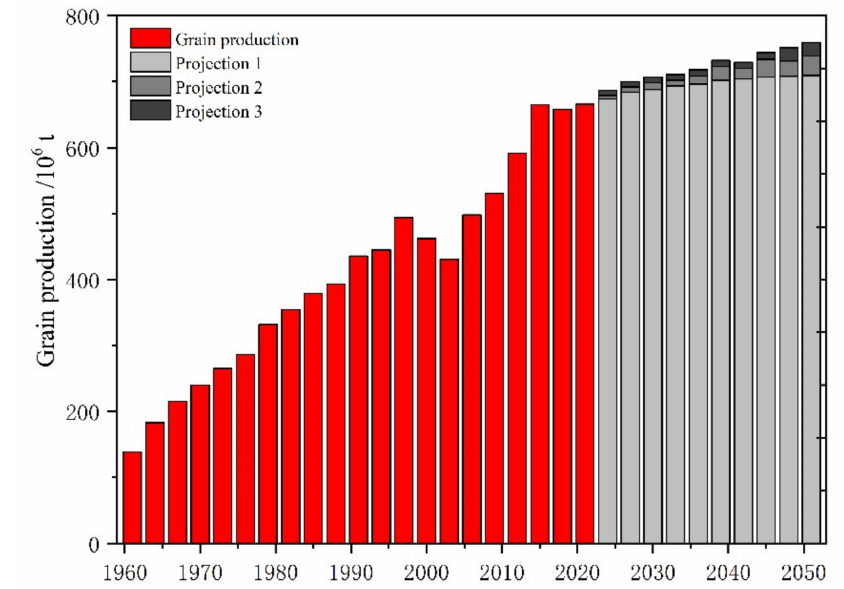
Figure 6. Projection of 3-grain production during 2020–2050. Projection 2: This alternative enhances the setting of the grain yield variable (P2). Assuming that China’s grain yields continue to grow at the current rate, calculated